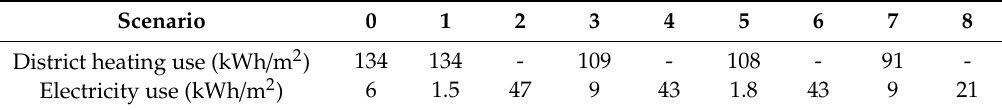
Table 4. Annual energy